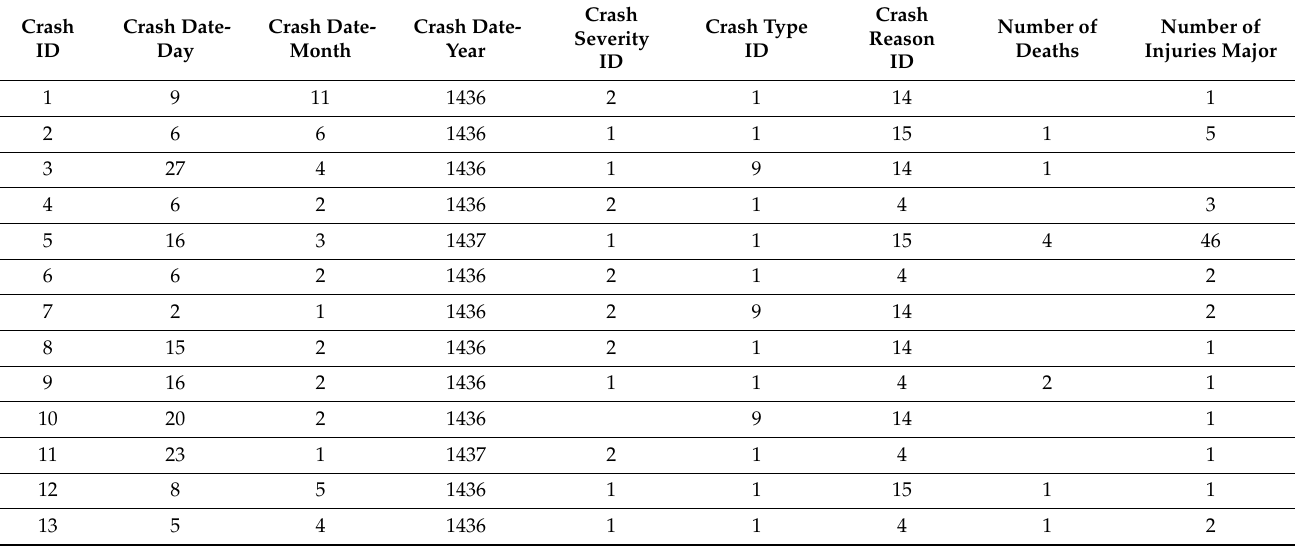
Table A1. Sample of crash data used for